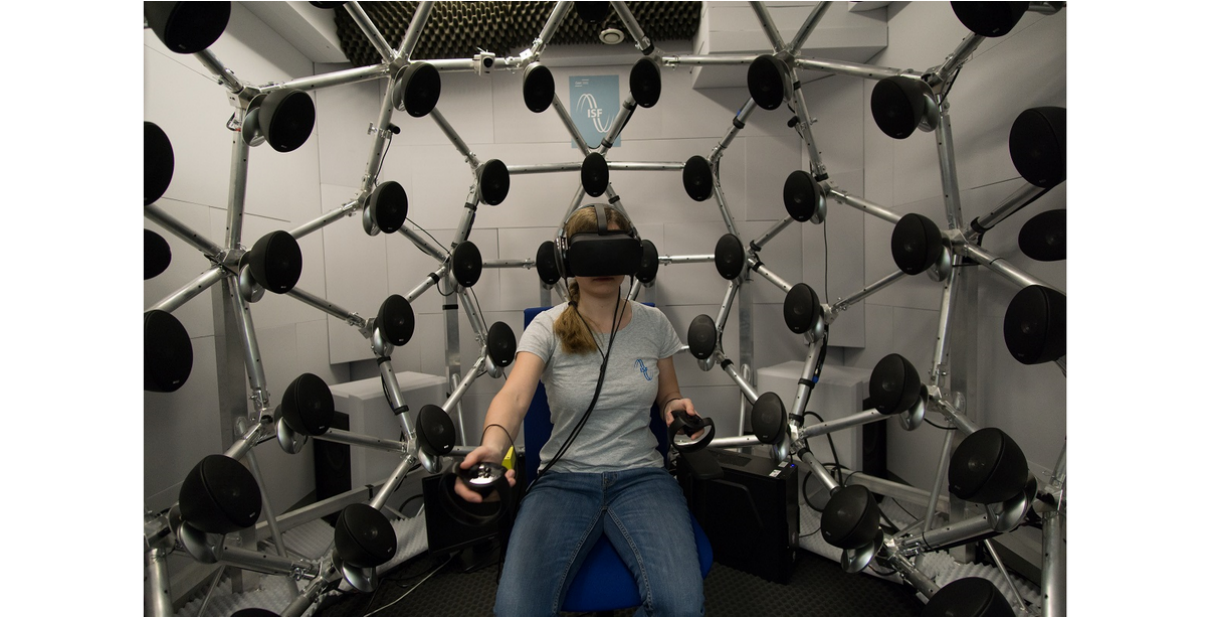
Figure 2. Experimental setup with the Oculus Rift head-mounted display in a semianechoic room. Test environment with open, dynamic, circumaural Sennheiser HD 650 headphones, 3 sensors for the tracking system, and touch controllers for switching the head-related transfer functions. The loudspeaker array was not in use in this